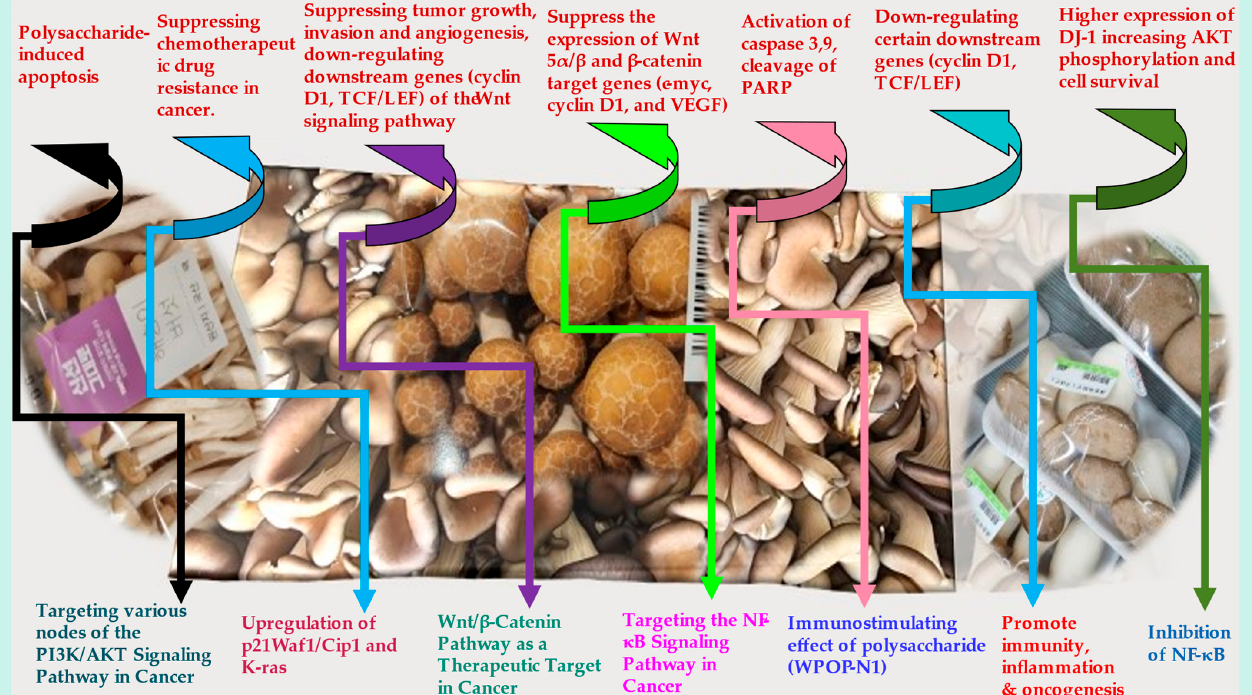
Figure 3. Overview of the anticancer mechanisms of mushroom/mushroom polysaccharides. Abbreviations: PI3Ks—phosphoinositide 3-kinases; AKT—serine/threonine protein kinase; TCF/LEF—T cell factor/lymphoid enhancer factor family; Wnt—wingless and Int-1; VEGF—vascular endothelial growth factor); PARP—poly adenosine diphosphate-ribose polymerase; DJ-1—Parkinson dis- ease protein 7; p21Waf1/Cip1—cyclin-dependent Kinase Inhibitor; K-ras—Kirsten rat sarcoma viral